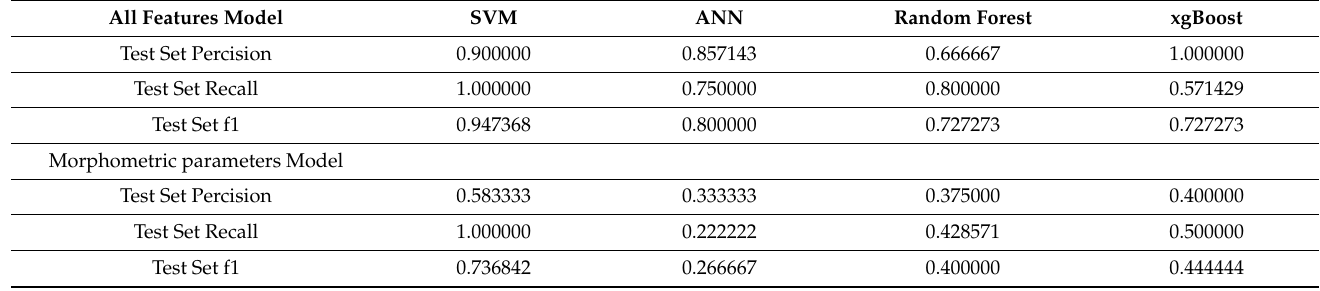
Table 5. Performance Comparison of Machine Learning model in Hydrocephalus Group Compared to Symptomatic Group.